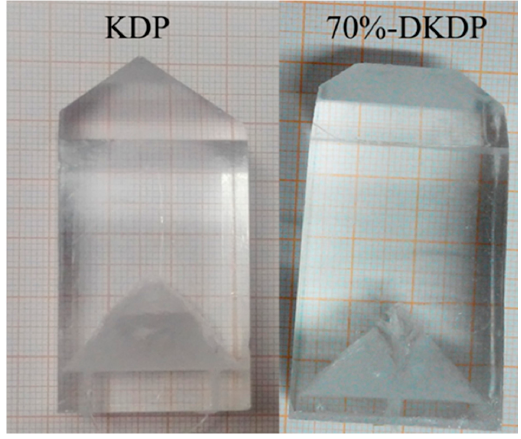
Figure 1. Photographs of the as-grown KDP and 70%-DKDP crystals.